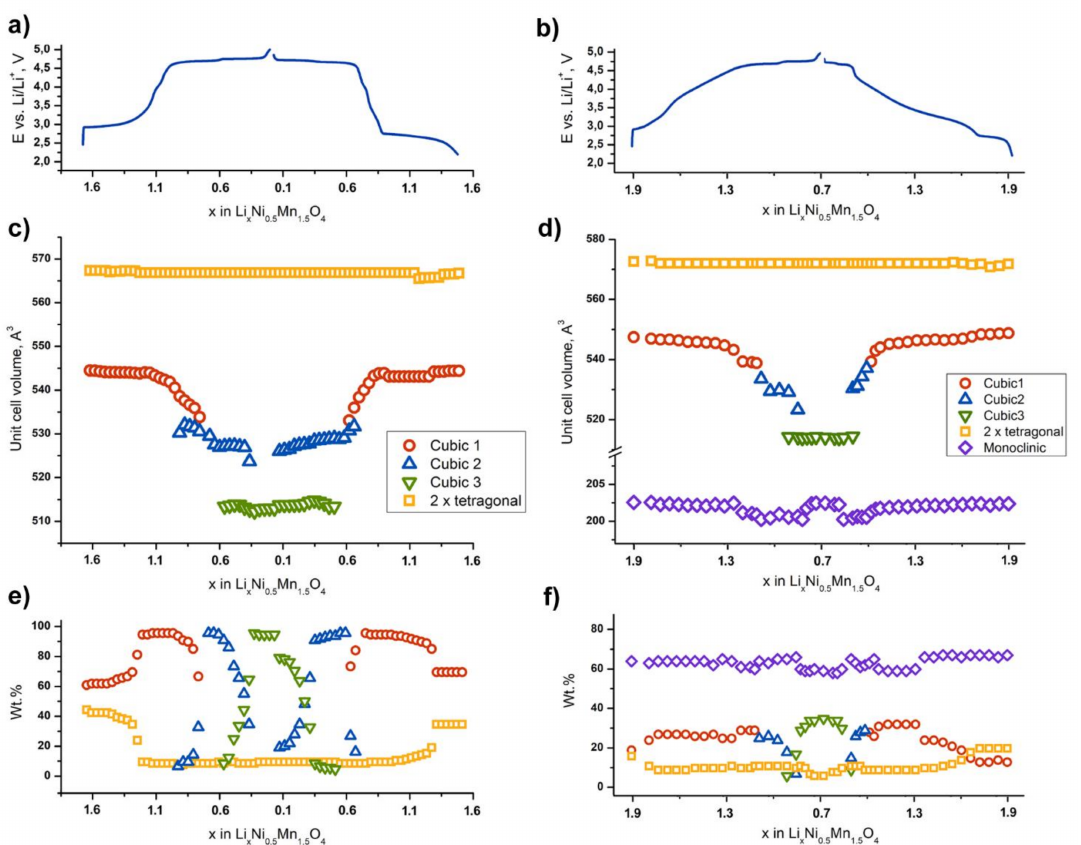
Figure 5. E–x curves and variation of the unit cell volumes and weight fractions of the phases for the LiNi 0.5 Mn 1.5 O 4 ( a , c , e ) and Li 2 Ni 0.5 Mn 1.5 O 4 ( b , d , f )